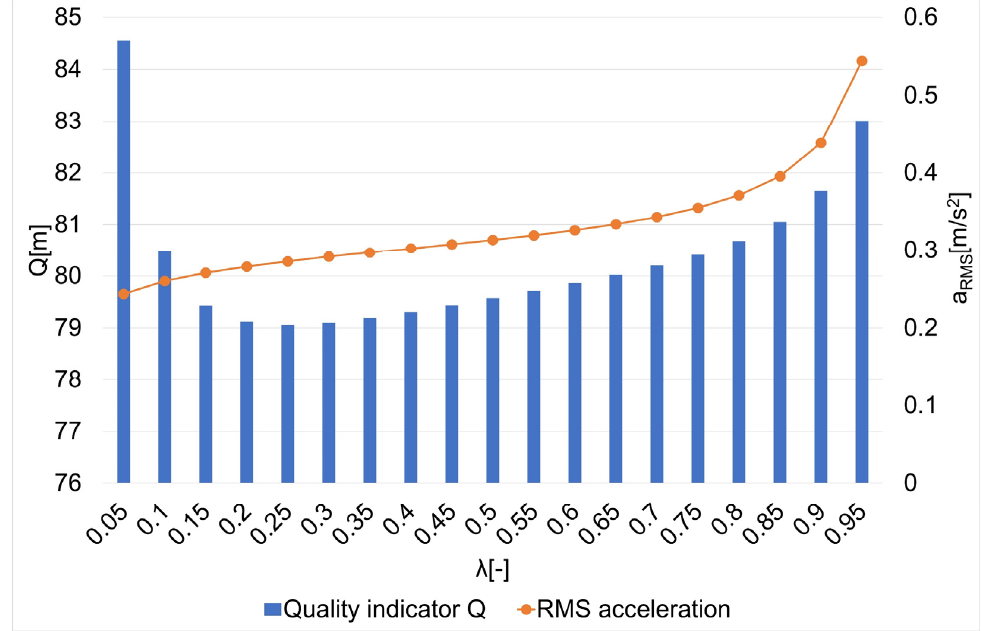
Figure 6. The values of the quality indicator Q and the mean square value of acceleration a RMS for the smoothing parameters in the case of path no. 2 [6].